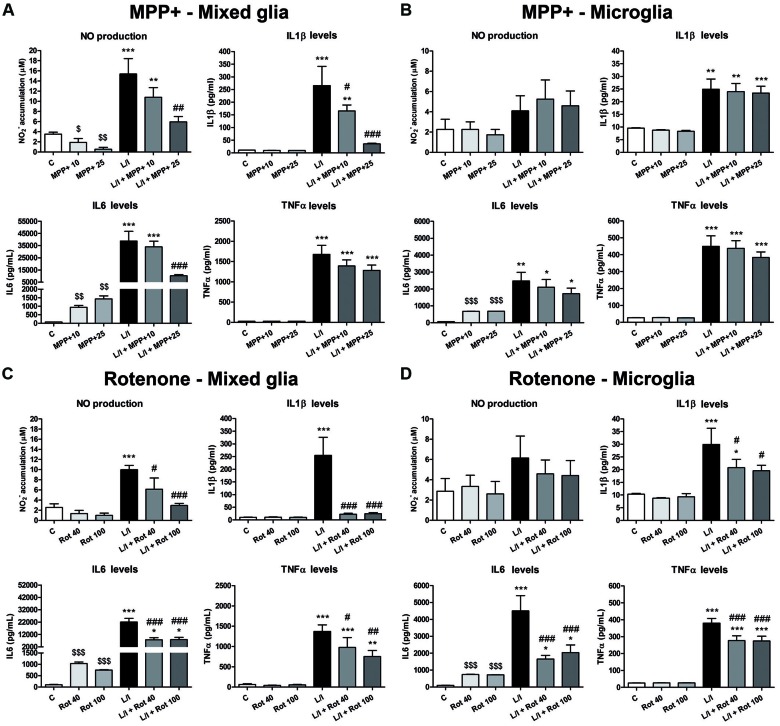
Nitric oxide (NO) and pro-inflammatory cytokine production in the primary glial cell cultures treated with MPP+ and rotenone. NO production was estimated from nitrite accumulation and IL1β, IL6 and TNFα levels were determined by ELISA in the culture medium of the MPP+-treated mixed glial (A) and microglial (B) cultures, and the rotenone (Rot)-treated mixed glial (C) and microglial (D) cultures. The cell cultures were treated with 10 and 25 μM MPP+ or 40 and 100 nM Rot for 24 h, in the absence or in the presence of LPS/IFN-γ (L/I). Bars are means ± SEM of four independent experiments. *p < 0.5, **p < 0.01 and ***p < 0.001 vs. control (C); #p < 0.05, ##p < 0.01 and ###p < 0.001 vs. L/I; one-way ANOVA and Newman-Keuls post-test. $p < 0.05, $$p < 0.01 and $$$p < 0.001 MPP+ and Rot alone vs. C, one-way ANOVA and Newman-Keuls post-test only considering the L/I-free groups. This latter analysis was performed to detect whether the high values observed in the L/I group may hinder the detection of a statistical significance of the effects of MPP+ and Rot alone.